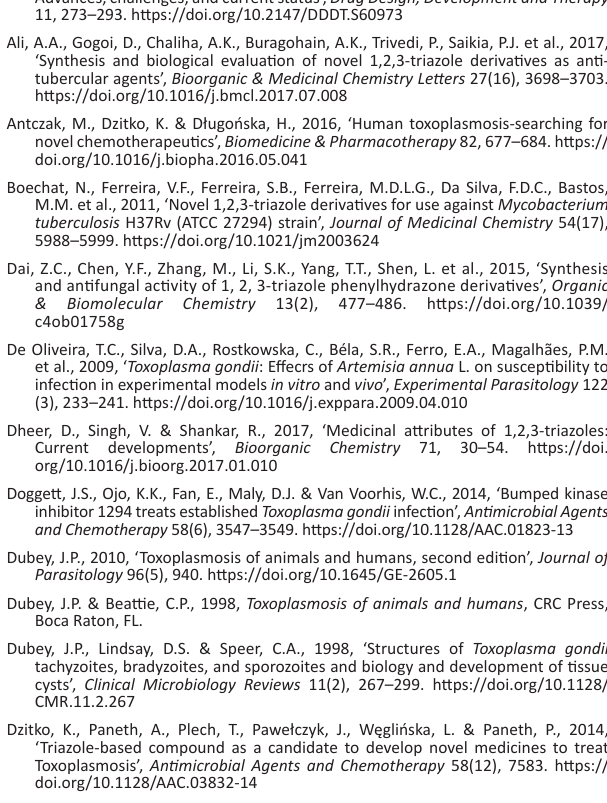
FIGURE 4: Effects of FJS-302, FJS-303, FJS-403 and FJS-INH on Toxoplasma gondii bradyzoite induction. (a) Representative images of the sulphadiazine (1 mg/mL), FJS-302 (50 µ g/mL), FJS-303 (50 µ g/mL), FJS-403 (50 µ g/mL) or FJS-INH (50 µ g/mL) treated wells. Red, SAG1; Green, GFP; Blue, DAPI. (b) GFP-positive parasitophorous vacuole (bradyzoite) number and anti-SAG1 positive parasitophorous vacuole (tachyzoite) number were counted. (c) GFP-positive parasitophorous vacuole rate was calculated by counting total parasitophorous vacuole and GFP-positive parasitophorous vacuole per image. Each bar represents the mean ± s.d. of three independent